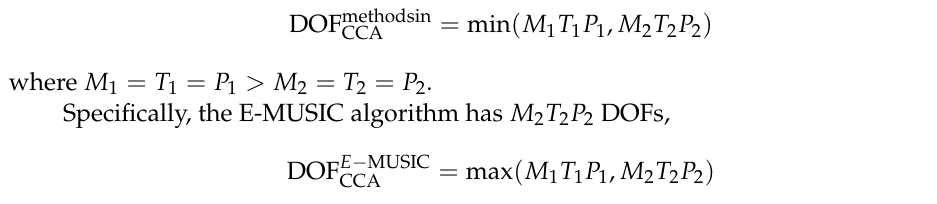
Figure 4. Algorithm complexity according to searching step.